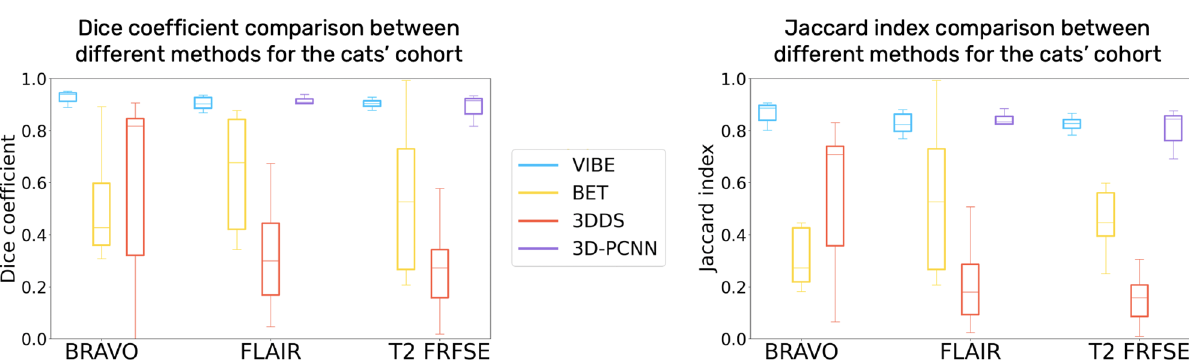
Figure 3. Dice similarity coefficient and Jaccard index Boxplot for the cats cohort, comparing VIBE, BET, 3DSS and 3D-PCNN for three different sequences: T1 BRAVO, T2 FLAIR and T2